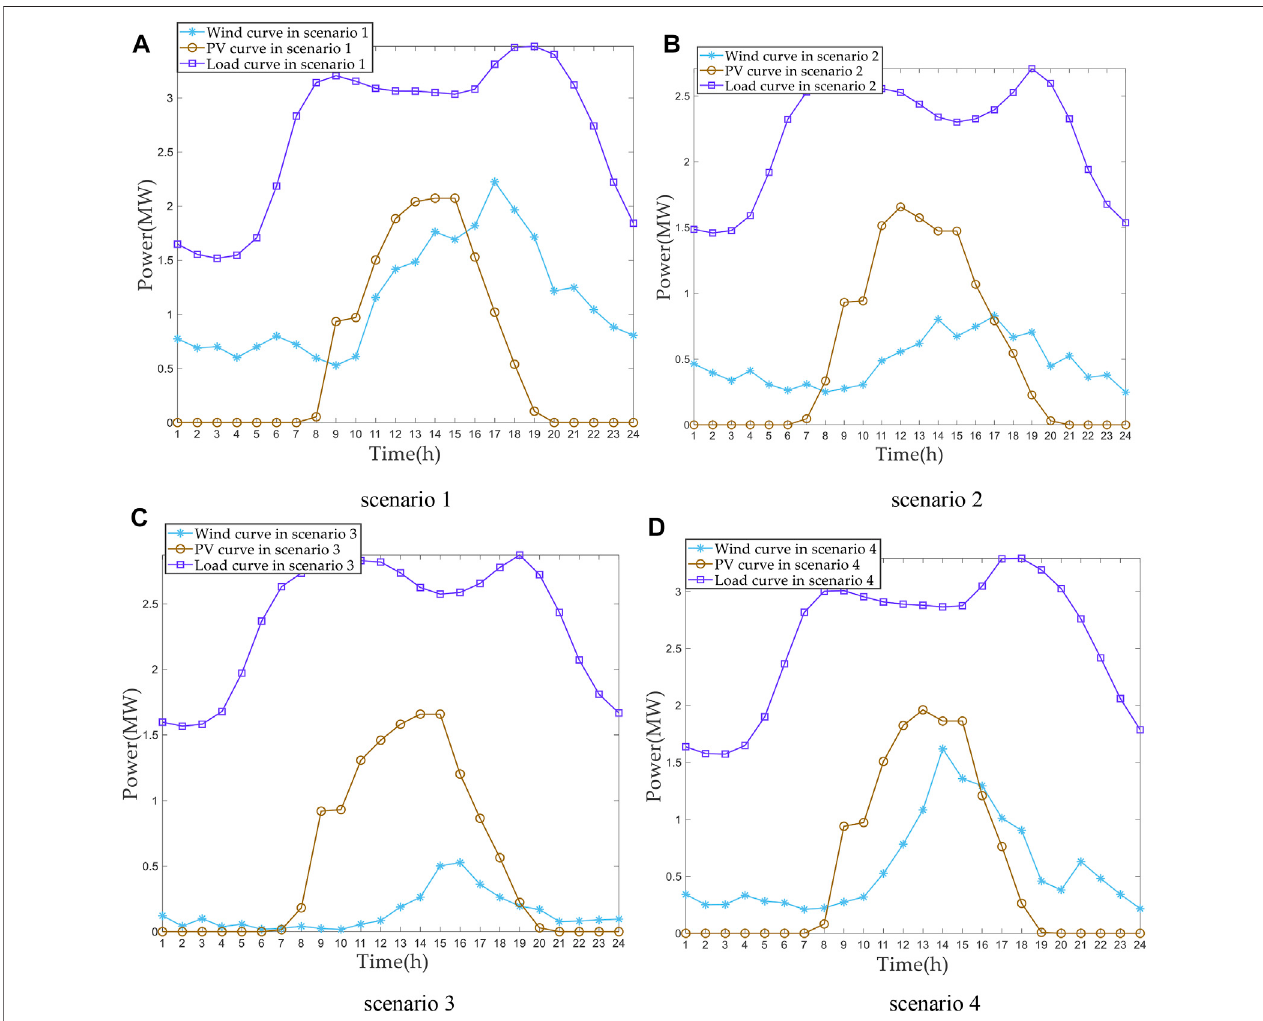
FIGURE 5 | Clustered four typical operating scenarios. (A) Scenario 1. (B) Scenario 2. (C) Scenario 3. (D) Scenario 4